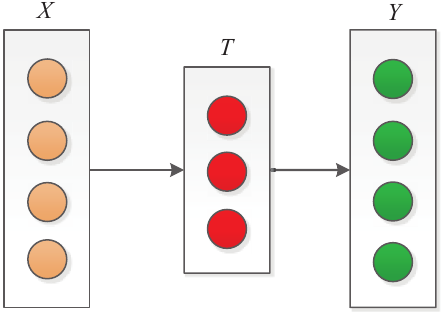
Figure 1. The structure of AutoEncoder. The encoder obtains the characteristic sequence T based on the original sequence X . The decoder gets the reconstructed sequence Y according to the characteristic sequence T